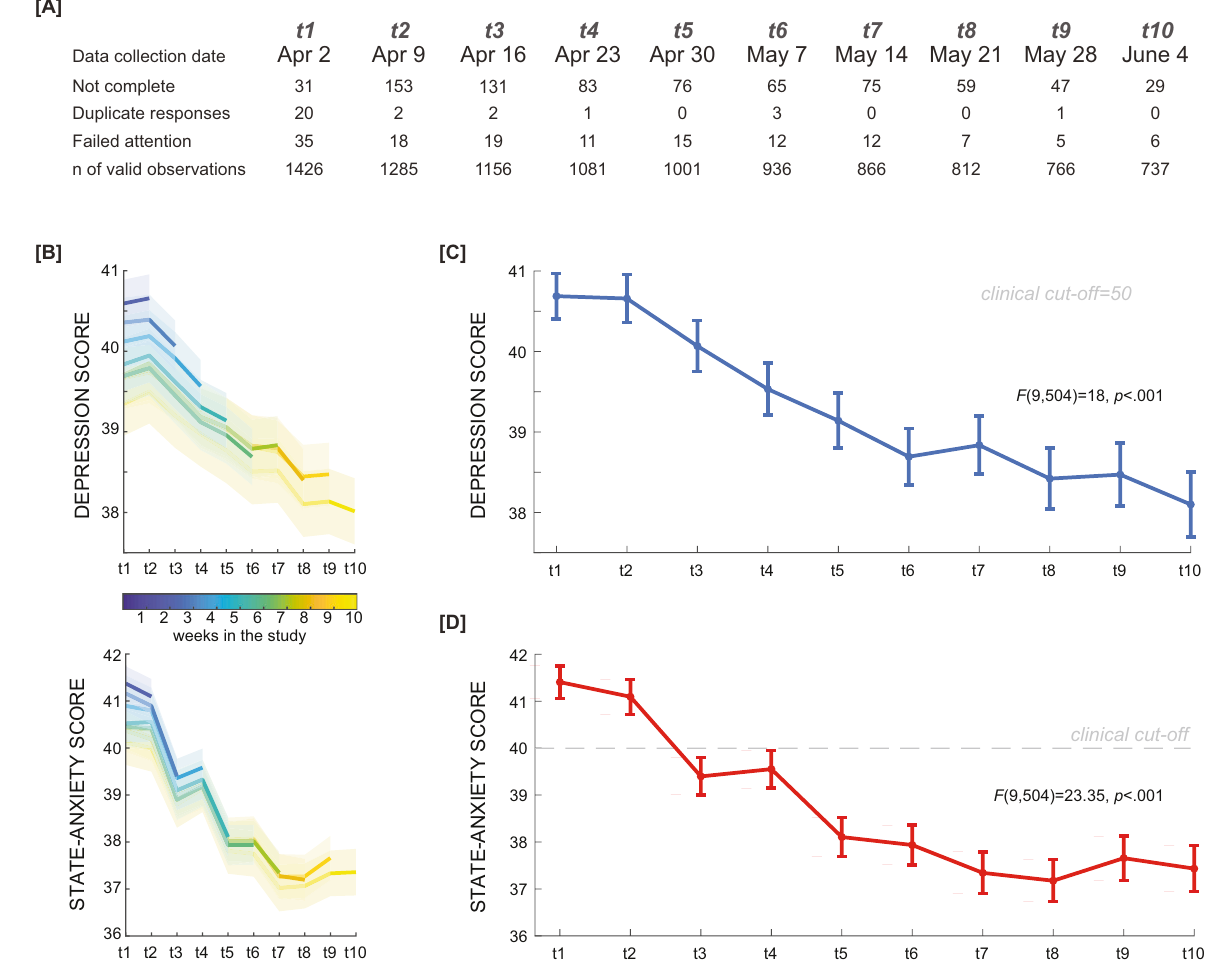
Fig. 1 Data collection timeline, with participant exclusion, and depression and anxiety scores. Longitudinal data were collected through weekly surveys for a 10-week period. A Drop-outs are presented alongside numbers of exclusions based on duplicate responses and failed attention checks. B Depression and anxiety trends in different subsets of participants. The blue line depicts depression (top panel) and anxiety (bottom panel) scores from participants with valid observations from the fi rst week of data collection ( n = 1456). The yellow line depicts scores from participants who successfully completed all 10 weeks of data collection ( n = 743). All other lines depict intermediate subsets of participants. The shaded area represents the standard error of the mean. C Depression and D state anxiety scores were measured weekly. Error bars indicate the standard error of the